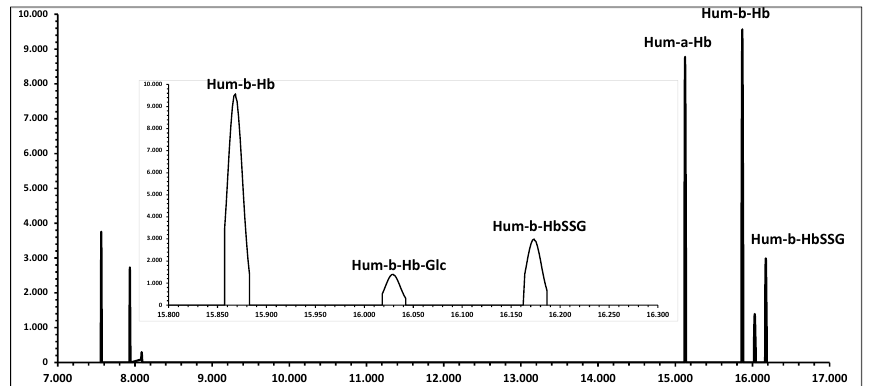
Figure 5. Simulated MALDI spectrum of a human red blood cell hemolysate with typical relative ratios of signals (see Table 1). The insert displays the expanded region of interest for the quantification of the ion signals for the measurement of glutathionyl-hemoglobin, as they appear at a resolution of 1000 DM/M.